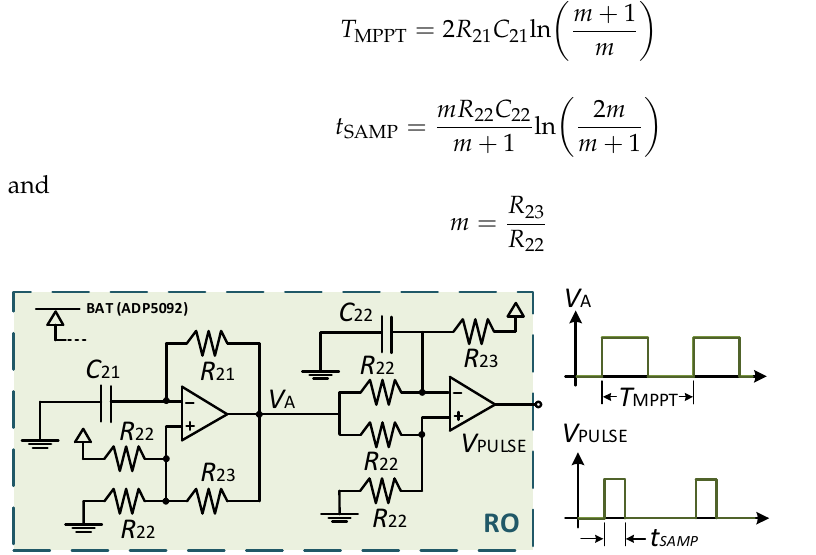
Figure 5. Relaxation oscillator (RO) for the generation of V PULSE .